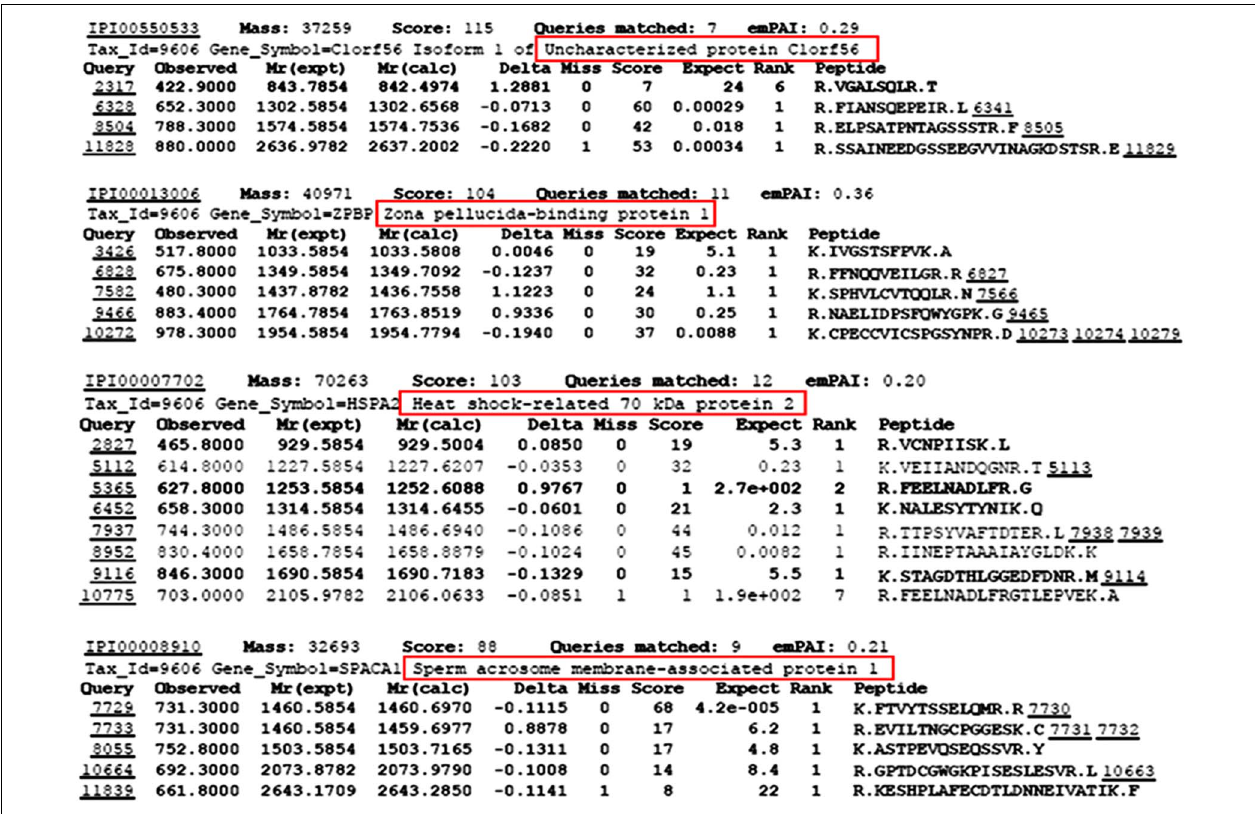
FIGURE 1 | Identification of SLeX/LeX-binding proteins from sperm membrane protein extracts using SLeX/LeX-BSA affinity chromatography followed by MALDI-TOF-MS/MS. Sperm membrane protein extracts were purified by membrane protein extraction kit (ProteoExtract native membrane protein Extraction Kit; Merck). Each MS/MS spectrum was searched against the Human IPI Protein Database